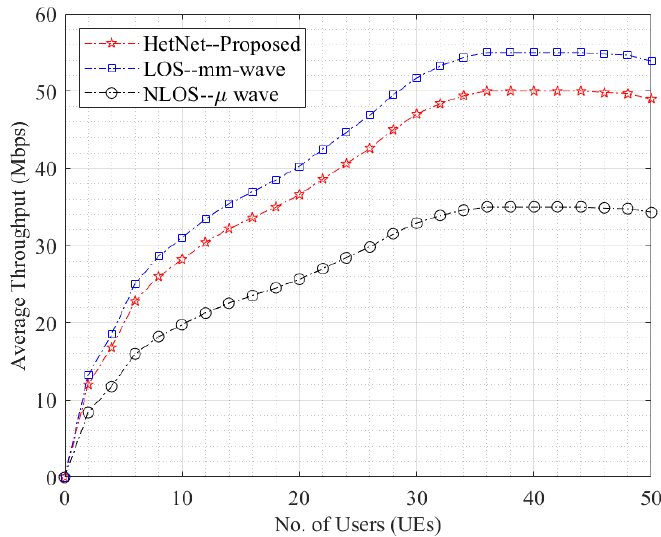
Figure 10. Throughput vs No. of UEs for LOS, NLOS, and HetNet.